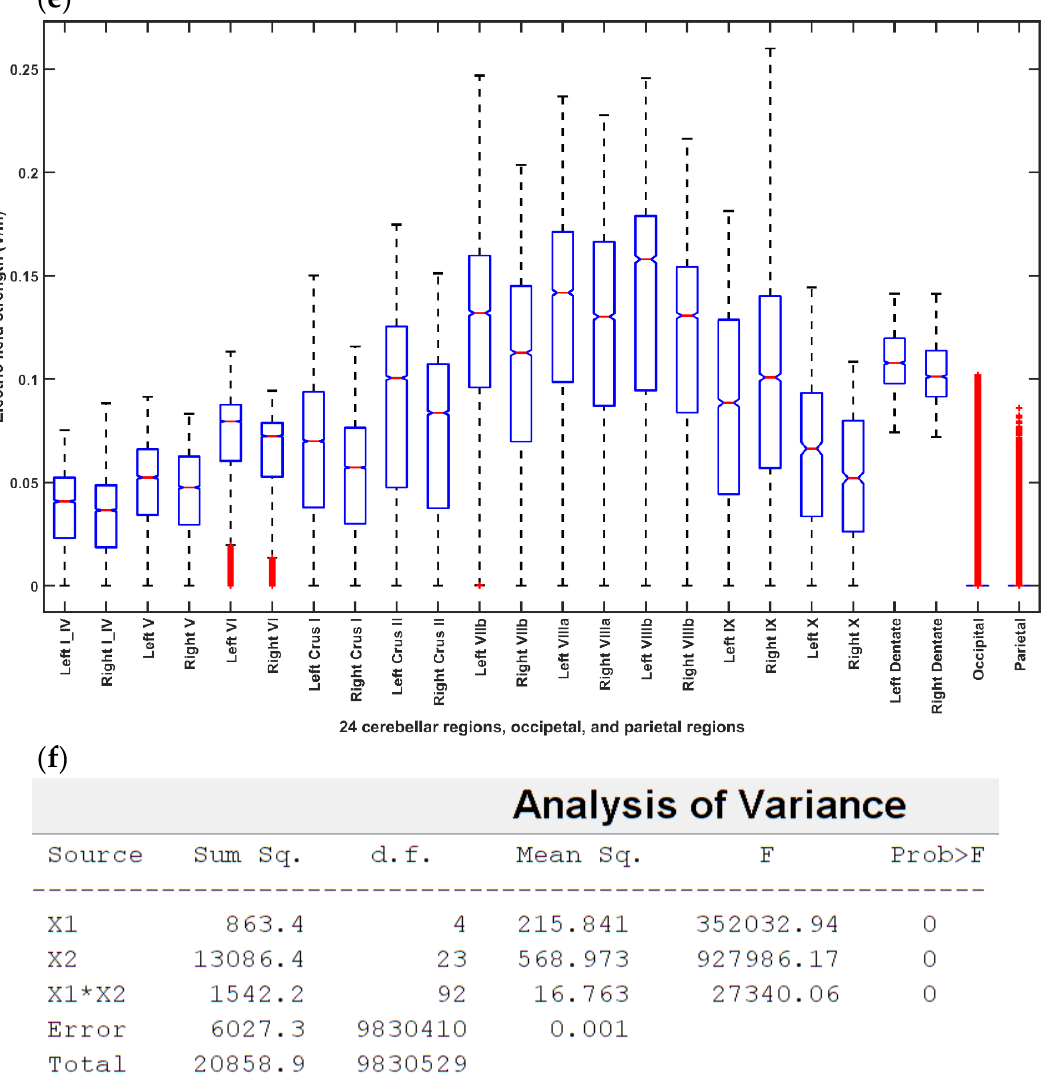
Figure 4. Boxplot of the electric field distribution for different ctDCS montages for the head model from the MRI template of 55-59 years age-group across 24 cerebellar regions, occipital and parietal lobes where in each box, the central mark indicates the median, and the bottom and top edges of the box indicate the 25th and 75th percentiles, respectively. The whiskers extend to the most extreme data points not considered outliers, and the outliers are plotted individually using the '+' symbol. If the notches in the box plot do not overlap, one can conclude, with 95% confidence that the true medians do differ. ( a ) Shows the EF distribution for the Celnik montage. ( b ) Shows the EF distribution for the Manto montage. ( c ) Shows the EF distribution for the Extracephalic montage. ( d ) Shows the EF distribution for the PO9h – PO10h montage for case 1 (Optimization for dentate nucleus). ( e ) Shows the EF distribution for the Exx7 – Exx8 montage for case 2 (Optimization for lobules VII-IX). ( f ) ANOVA table: Two-way ANOVA for the factors of interest – montages (X1), brain regions (X2), and their interactions (montage* brain region) – all found significant. Source: Source of variability; Sum Sq.: Sum of Squares due to each source; d. f.: Degrees of freedom associated with each source; Mean Sq.: Mean Square for each source, which is the ratio Sum Sq. /d. f. F: statistics which is the ratio of the mean squares.